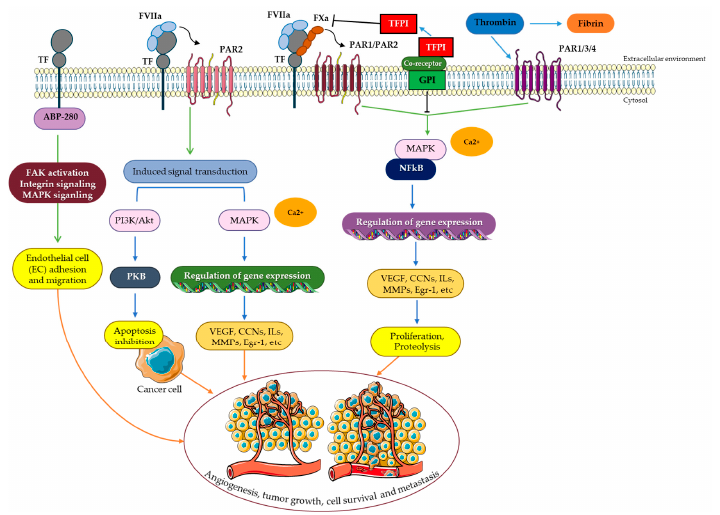
Figure 3. Possible mechanisms of expression and functional regulation of tissue factor and coagulation factor VII in cancer cells. Schematic overview summarizing the multiple mechanisms of gene expression, functional tuning, and intracellular signaling in cancer cells, as described in this review. It has been suggested that cancer cell phenotypes associated with the TF-fVII pathway may be spe- cifically controlled via multiple autocrine and/or paracrine mechanisms, depending on tumor mi- croenvironmental conditions. Parts of the figure were drawn using pictures from Servier Medical Art. (accessed on 16 May 2022).